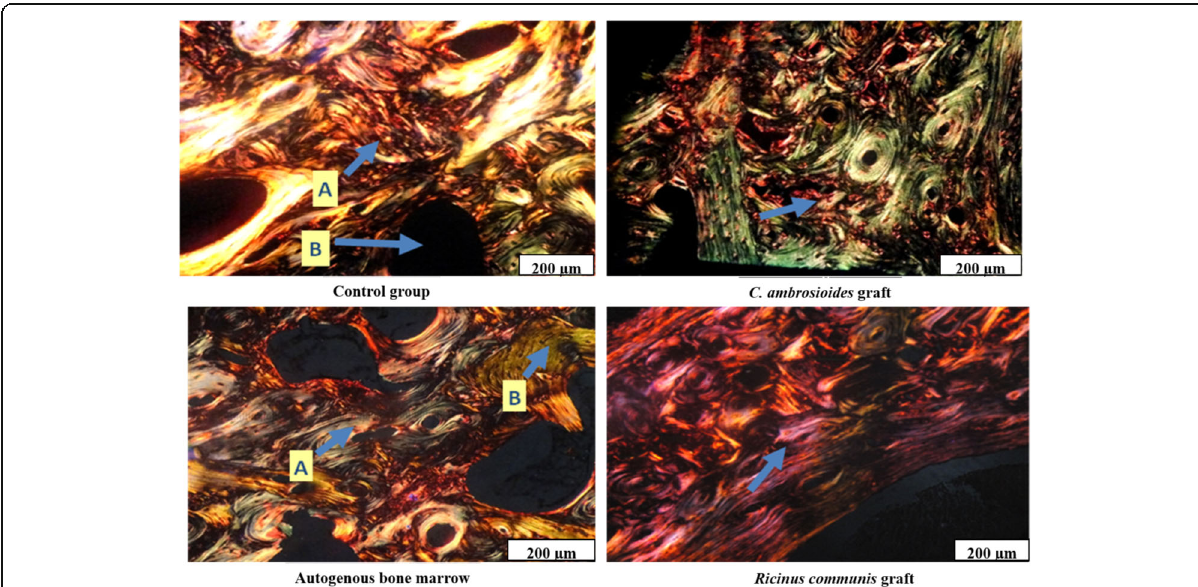
Fig. 7 Effect of lyophilized aqueous Chenopodium ambrosioides extract on bone formation 30 days after application. Histology photomicrographs of collagen organization of bone remodeling in a complete diaphyseal fracture of the radius of rabbits. Control group: ( a ) non-organized collagen and ( b ) beginning of osteon formation. C. ambrosioides graft: mature osteon. Autogenous bone marrow: predominance of non-lamellar bone tissue. Ricinus communis graft: ( a ) predominance of a forming osteon and ( b ) non-organized collagen. Sirius red staining under polarized light (200 μ